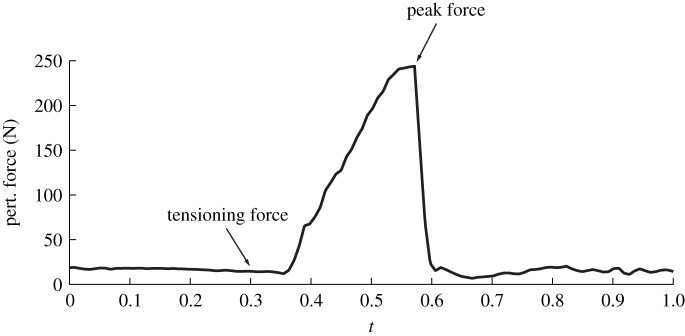
A typical perturbation time series is shown in this figure. This particular perturbation was a forwards perturbation at the medium force level. A baseline tensioning force of 19.6 N is commanded, until the start of the perturbation. The force quickly ramps up to a specified peak, then back down to the baseline tensioning force.